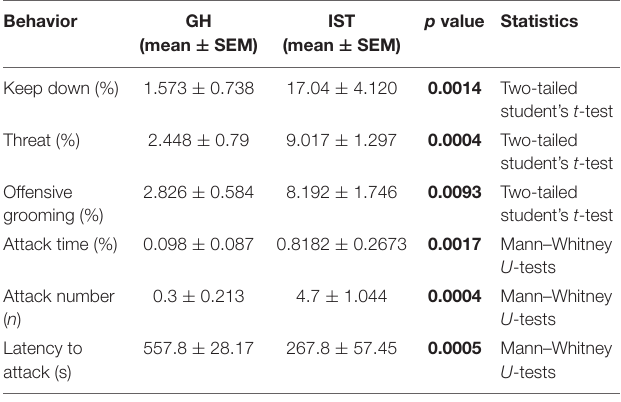
TABLE 2 | Detailed analysis of aggressive behaviors displayed during the FIT by isolated and trained (IST) and group-housed (GH) females (Experiment 1 and Figure 1 ) n = 10.